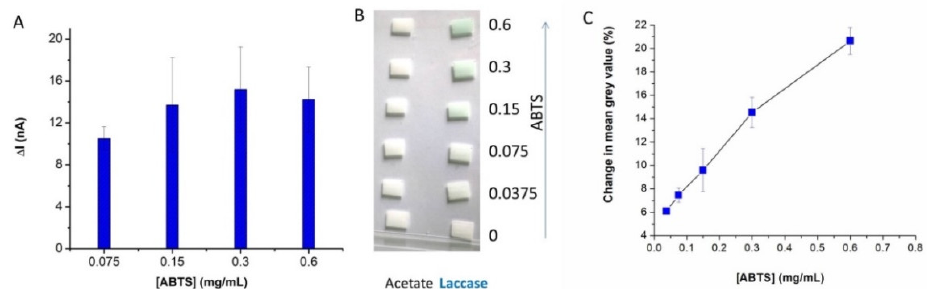
Figure 4. ( A ) Influence of the concentration of ABTS in the impregnating solution of the paper sensor on the magnitude of the current recorded at 0 V in the presence of 3.5 U/mL laccase. ( B ) Color intensity of the paper sensors made with ABTS solutions of increasing concentrations in the range 0.0375 mg/mL–0.6 mg/mL after 10 min of reaction with 1.1 U/mL laccase. ( C ) The corresponding change in the mean gray value of the laccase-treated paper sensors in ( B ).